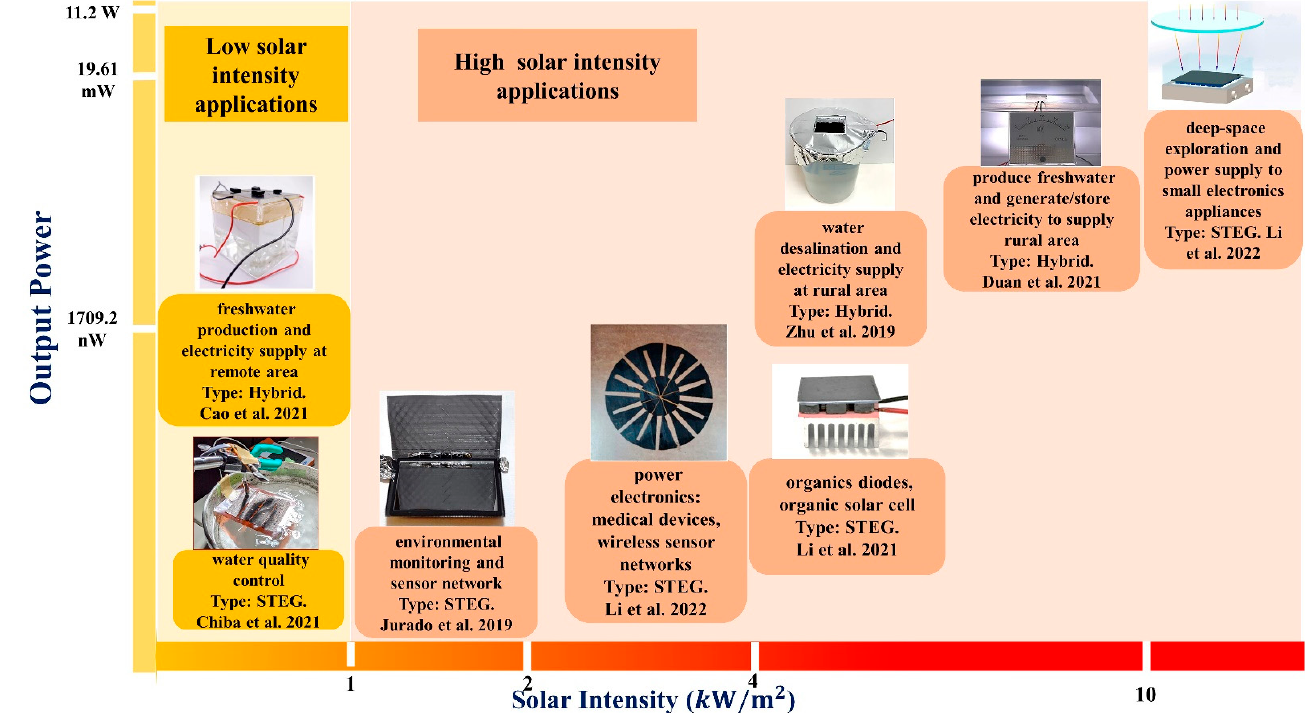
Figure 6. Application of CNT-based hybrid generators (water and electricity) (reproduced with permission, Copyright 2021 American Chemical Society [72]; reproduced with permission, Copyright 2019 John Wiley and Sons [73]; reproduced with permission, Copyright 2021 Elsevier [74]). CNT-based STEG (reproduced with permission, Copyright 2021, The Authors, Springer Nature [75]; reproduced with permission, Copyright 2019, The Authors, John Wiley and Sons [76]; reproduced with permission, Copyright 2022 Elsevier [77]; reproduced with permission, Copyright 2021 Elsevier [71]; reproduced with permission, Copyright 2019 Elsevier [78]).